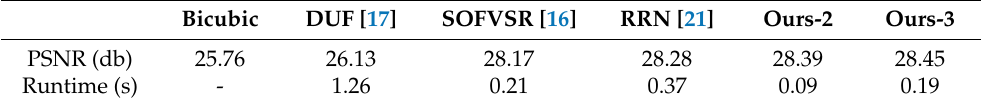
Table 1. Quantitative comparison on the realistic and dynamic scenes (REDS)